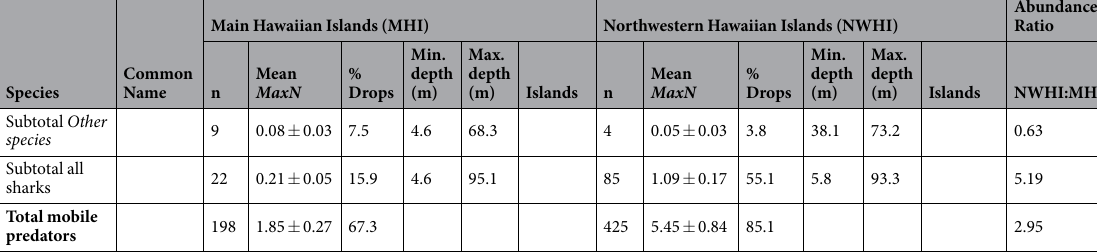
Table 2. Average abundance (mean MaxN ), standard error (SE), and NWHI:MHI abundance ratios for roving predator species sampled in the Hawaiian Archipelago. % Drops indicate the percentage number of BRUVS deployments where a species or group is observed. FFS: French Frigate shoals, LIS: Lisianski, PHR: Pearl and Hermes Reef, MID: Midway. * Seriola sp . that could not be differentiated between Seriola dumerili and